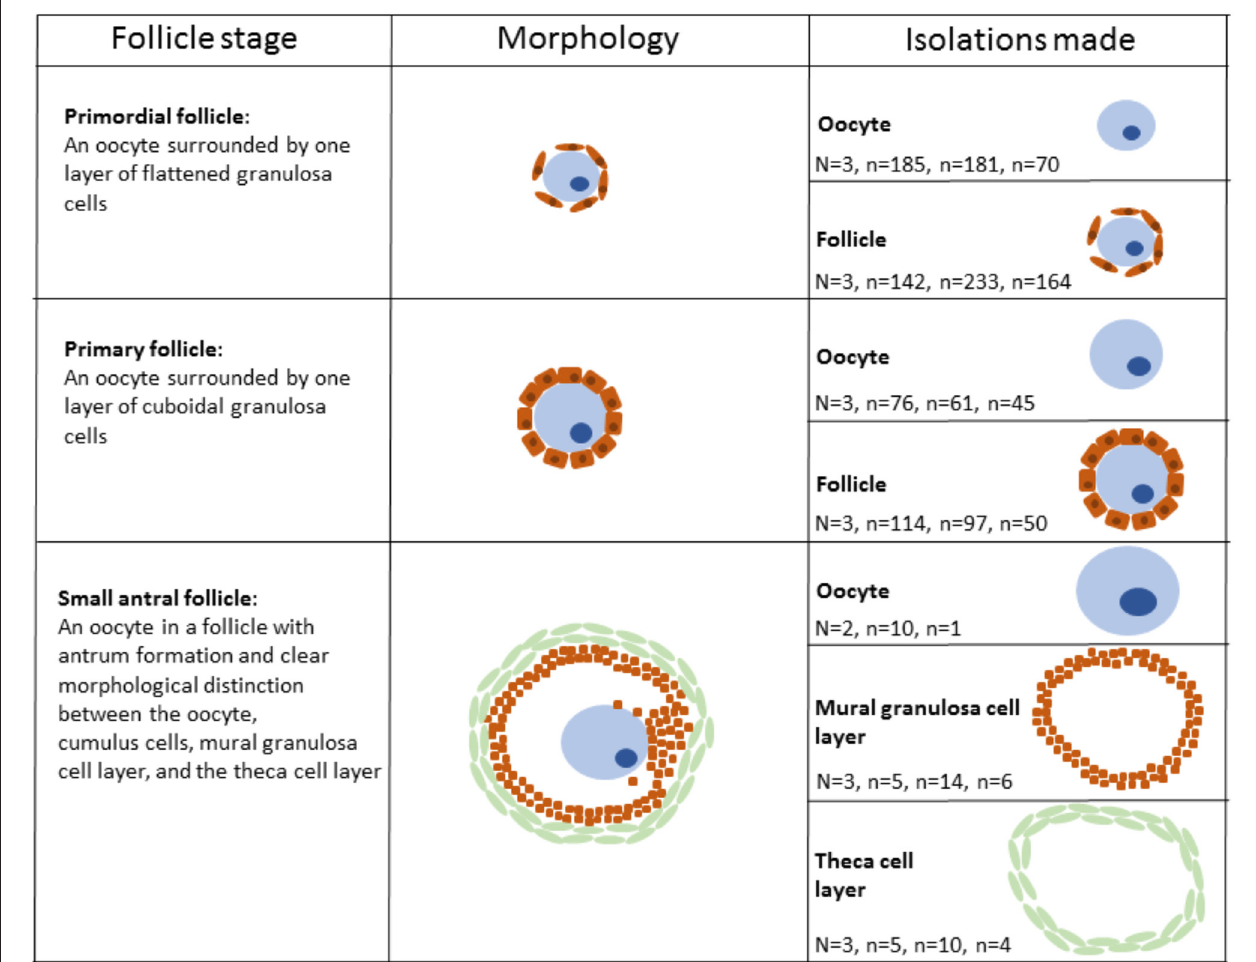
FIGURE 1 | Schematic illustration of human follicular cells isolated using laser capture microdissection. Please note that the aspect ratio is arbitrary.